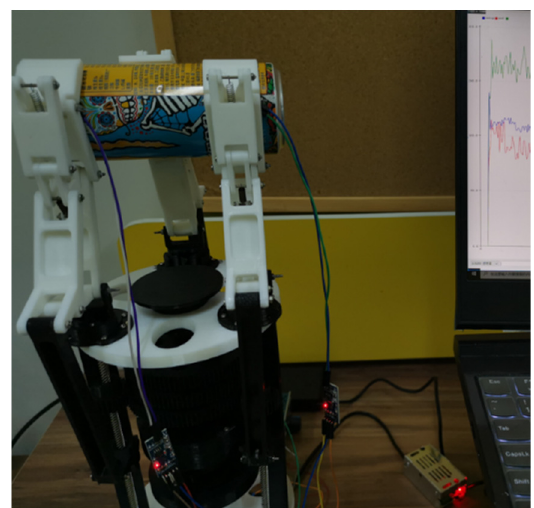
Figure 17. Grabbing a cylinder experiment.